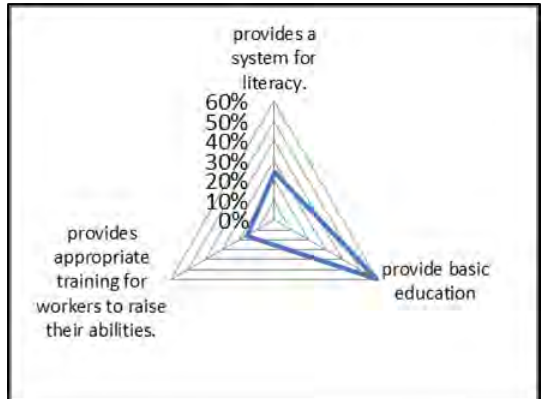
Figure 6. Support